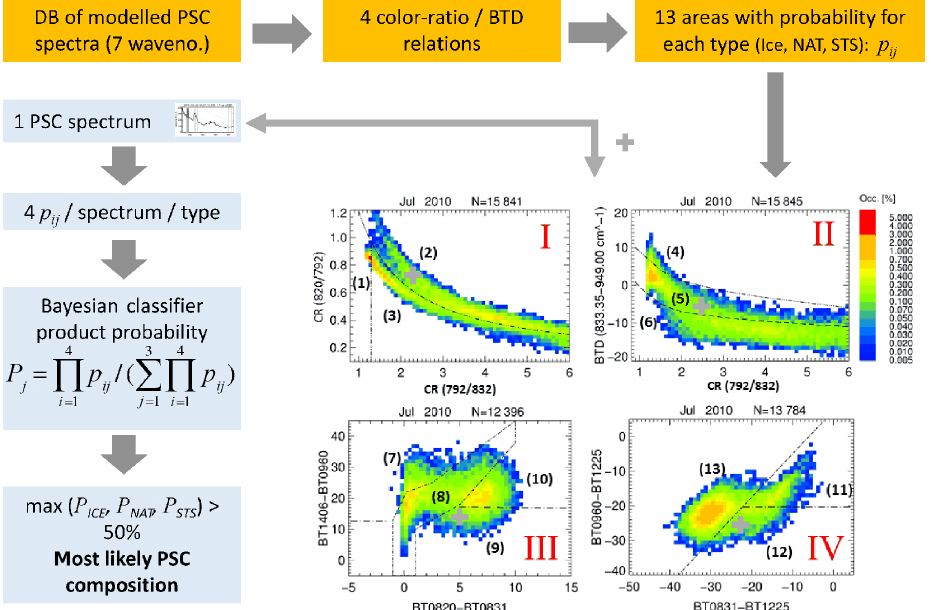
Figure 1. Schematic diagram of the Bayesian classifier procedure (blue boxes) for the MIPAS PSC type classification. Orange boxes illustrate the part of the huge database (DB) of modelled PSC spectra for the computation of colour ratios and BTDs. The diagrams I to IV are MIPAS examples of monthly probability density functions for SH July 2010 data applied in the Bayesian classifier. The grey cross in each of the four diagrams is illustrating the input information of a single PSC spectrum, which is used to retrieve the most likely PSC composition (for details, see text and Spang et al.,